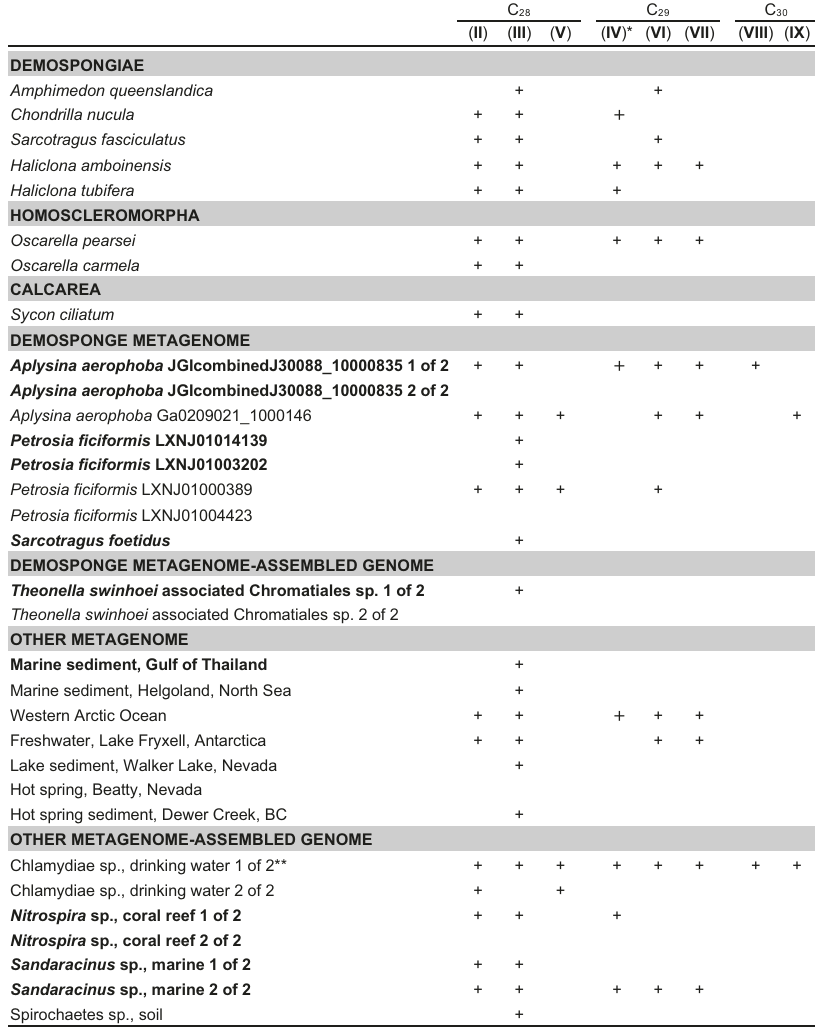
Metagenomic SMTs identi fi ed in gene clusters with at least two other sterol bio- synthesishomologsarebolded.*NMRcon fi rmedepiclerosterolandnotclerosterol as products of the “ Aplysina aerophoba JGIcombinedJ30088_10000835 1 of 2 ” and “ Chlamydiae sp., drinking water 1 of 2 ” sterol methyltransferases. **24-iso- propylcholesta-5,23-dienol was also detected as a product of the “ Chlamydiae sp., drinking water 1 of 2 ” sterol methyltransferase by NMR, but was not detected by